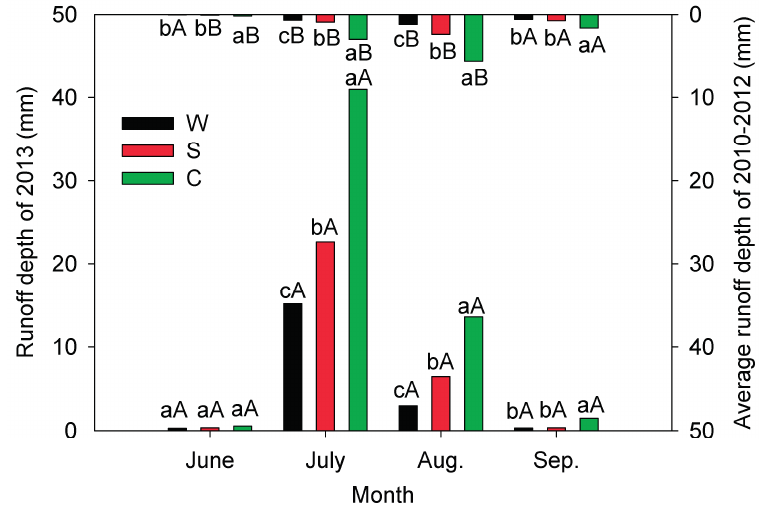
Figure 5. Monthly runoff depth in the “extreme year” and “normal year”. The capital letters represent the significance of the difference ( p < 0.05) between the “extreme year” and “normal year” for one land use type in one month, whereas the lower-case letters in the figure represent the significance of the difference ( p < 0.05) among different land-use types for one month in the same year. If one common letter is displayed, the difference is not significant; if different letters are displayed, the difference is significant. For example, the green bar was marked with “A” in August 2013, and that of 2010–2012 was marked with “B”, so the difference of runoff depths represented by two green bars was significant; green, red and black bar in July 2013 was marked with “a”, “b” and “c”, respectively, which meant that the difference of runoff depths among land-use types was significant. The same is the case for Figures 6–9.